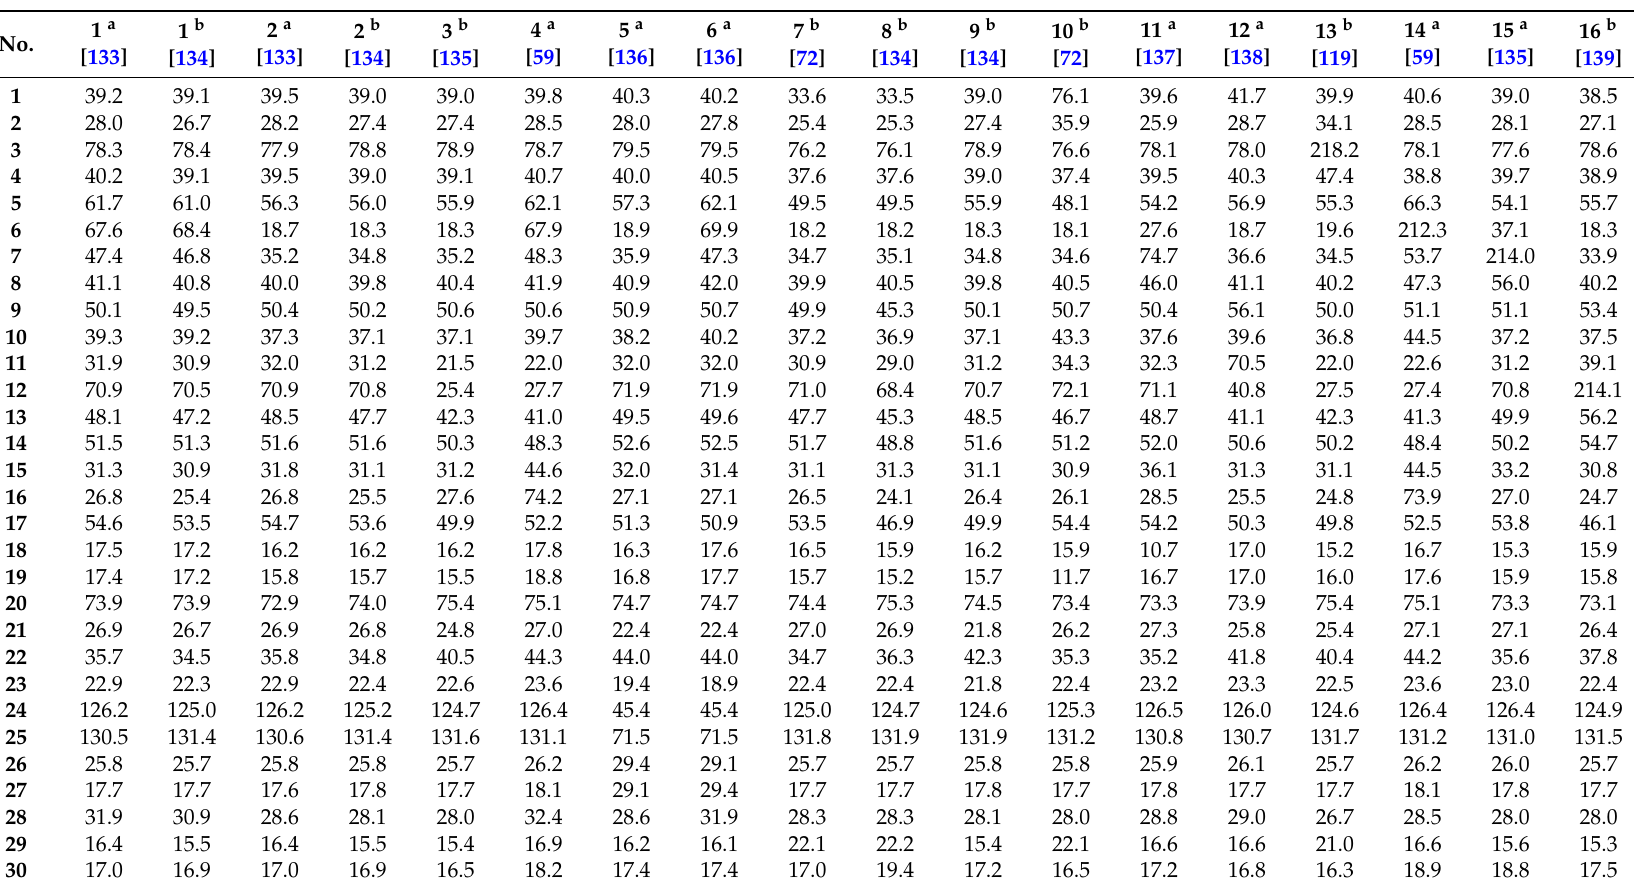
Table 2. 13 C-NMR data for the aglycone parts of compounds 1 – 33